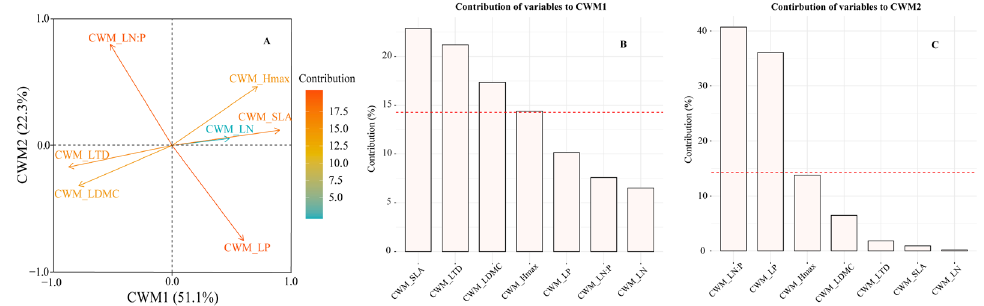
Figure 3. The principal component analysis (PCA) for community-weighted mean (CWM) traits ( A ). The contribution of each community-level trait to CWM1 ( B ) and CWM2 variables ( C ). The red dotted line on bar charts indicates the mean contribution of all seven community-level traits to CWM1 and CWM2 variables. LN, leaf N content; LP, leaf P content; LN/P, leaf N/P ratio; SLA, specific leaf area; LTD, leaf tissue density; LDMC, leaf dry matter content; H max , maximum plant height.